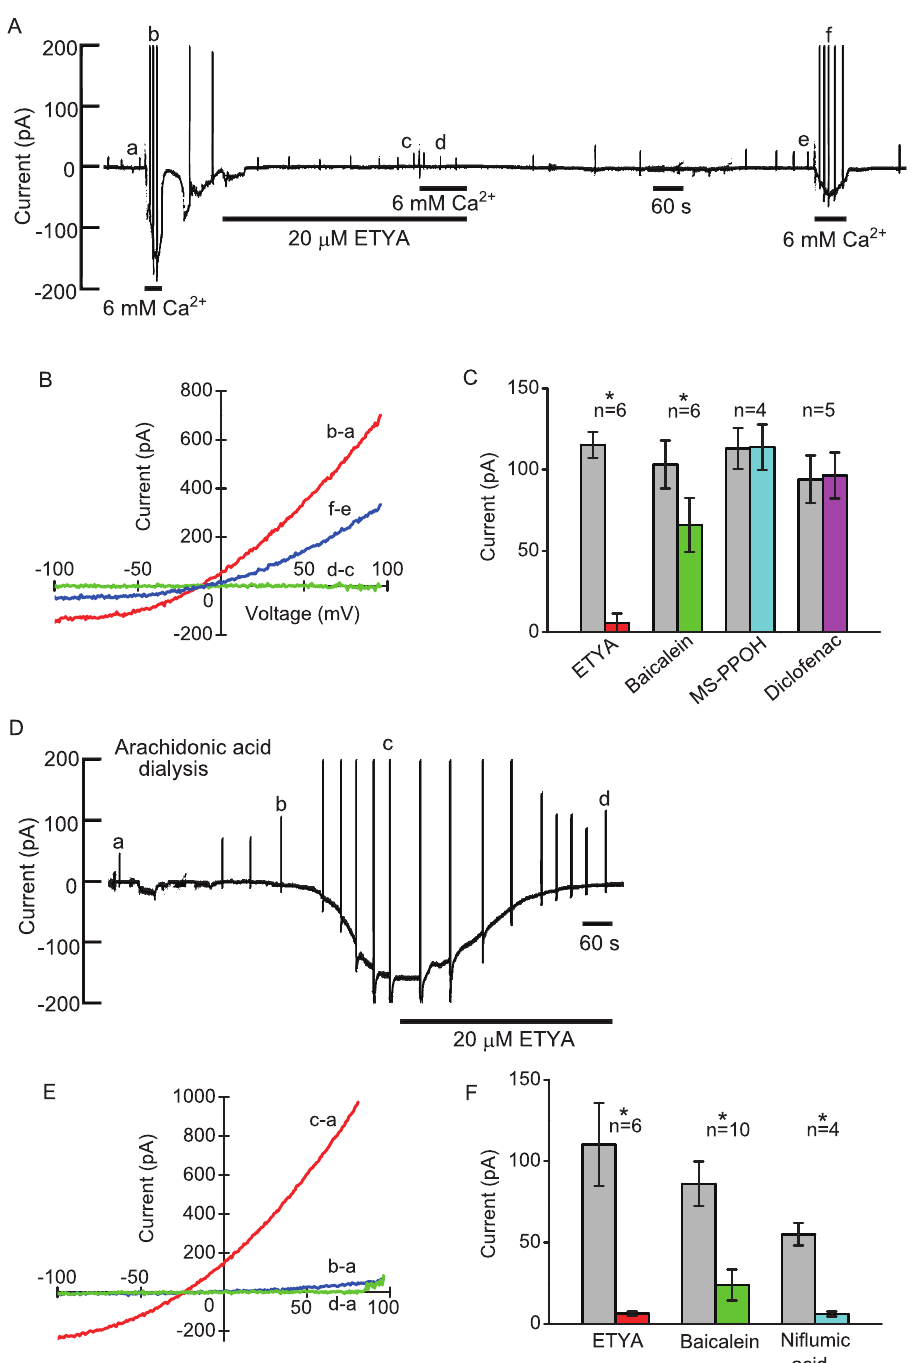
Figure 7. Effects of arachidonic acid-related drugs on the current signals. (A)The pen recording of the inhibitory effect of ETYA on extracellular Ca 2 + -induced current at 2 54 mV. (B) The plots of the whole-cell I/V relationships during control, ETYA application and wash-out. The relationships were obtained from the pen recording on the upper. (C) Comparison of the effects of external 20 m M ETYA, 20 m M baicalein, 20 m M MS- PPOH and 20 m M dicrofenac on extracellular Ca 2 + -induced current at 2 54 mV. In Figure 7A, B and C, the pipette solution contained amphotericin B (133 m g/ml). (D) The pen recording of the current signal measured at 2 54 mV during 50 m M arachidonic acid dialysis. (E) The plots of the whole-cell I/ V relationships during arachidonic acid dialysis. I/V relationships were obtained from the pen recording on the upper. (F) Comparison of effects of external 20 m M ETYA, 20 m M baicalein and 100 m M niflumic acid on intracellular arachidonic acid-induced current at 2 54 mV. doi:10.1371/journal.pone.0019158.g007 utes did not recover the arachidonic acid-induced current. Lu hand, the IP 3 -independent Ca 2 + store should be refilled by an et al. [23] identified expression and association of TRPC channels innate mechanism. In the present experiment, the wash-out of with Orai1 and STIM1 in human parathyroid. Ca 2 + -free saline solution with normal saline solution for 10 min-